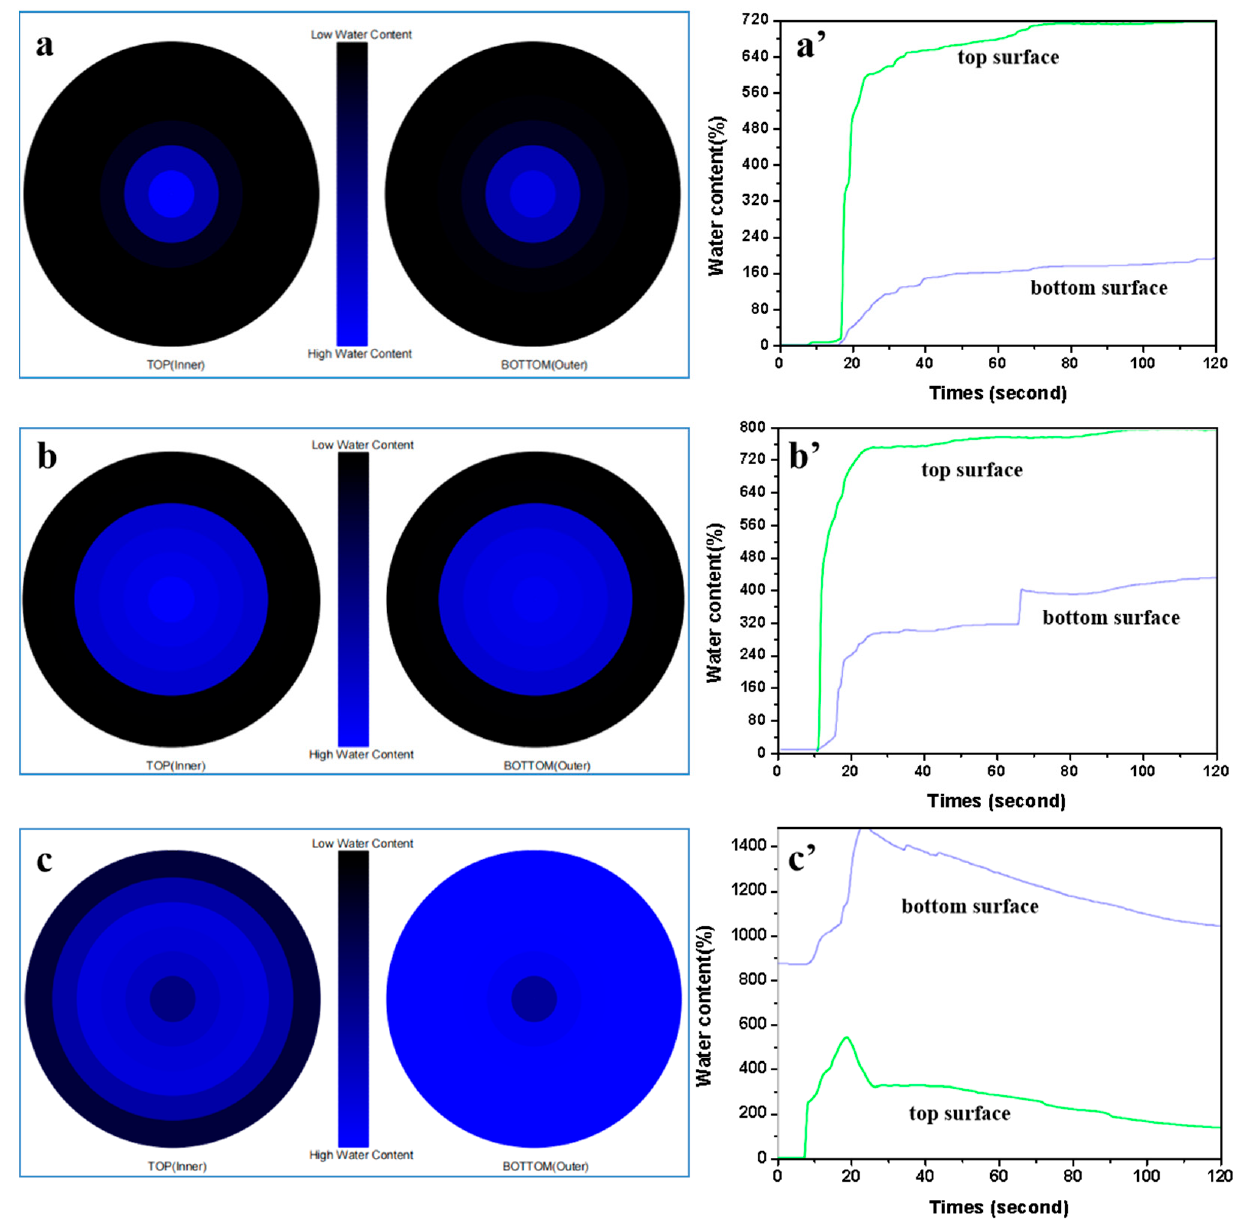
Figure 9. Water location ( a–c ) and water content vs. time ( a’–c’ ) of ( a,a’ ) the pristine PET, ( b,b’ ) CSMs and ( c,c’ ) HMs -finished PET fabrics.